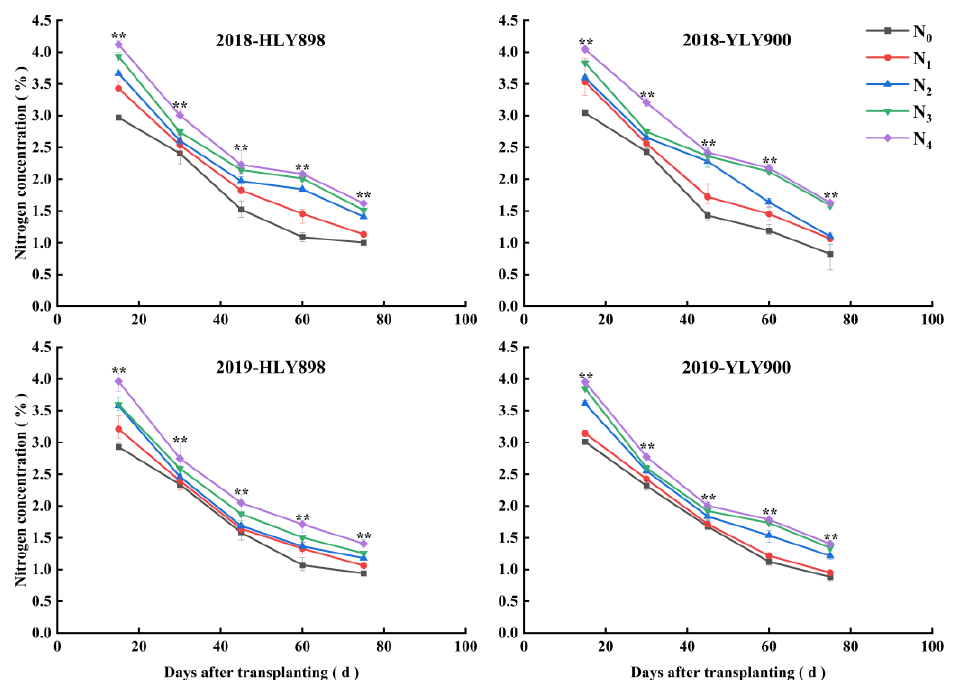
Figure 4. Dynamic changes in the N concentration (%) according to days after transplanting (d) shown for the varieties Huiliangyou 898 (HLY 898) and Yliangyou 900 (YLY 900) according to the season (2018 or 2019). ** indicates significance at the 0.01 level.